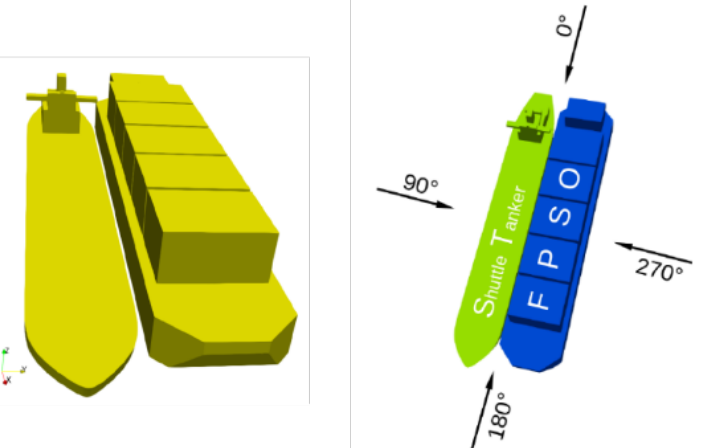
Figure 14. Configuration of FPSO and shuttle tanker and incidence angles for the CFD simula- tions.